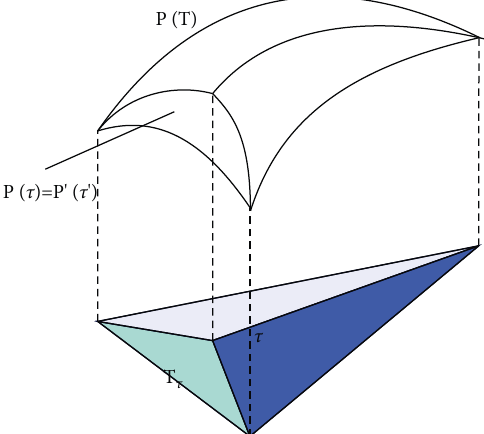
Figure 4: Triangle and surface patch segmentation in the common edge domain.